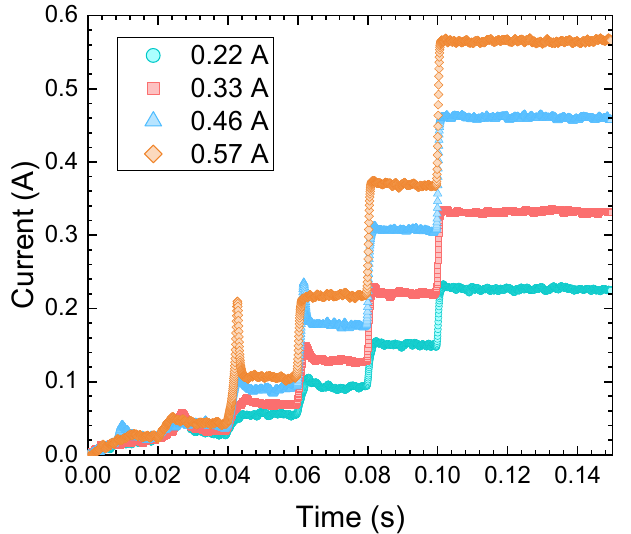
Figure 3. Stepwise electric current supply during the electrical sintering of the Ag NP lines.